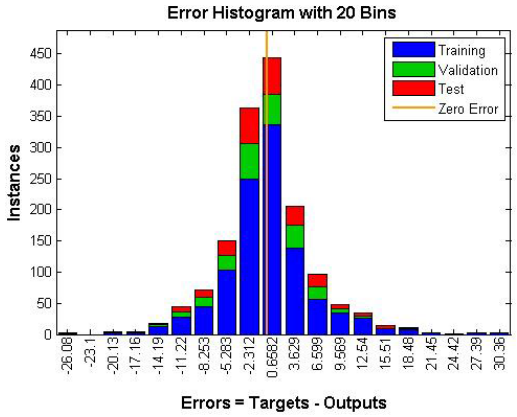
Figure 16. Performance plot.